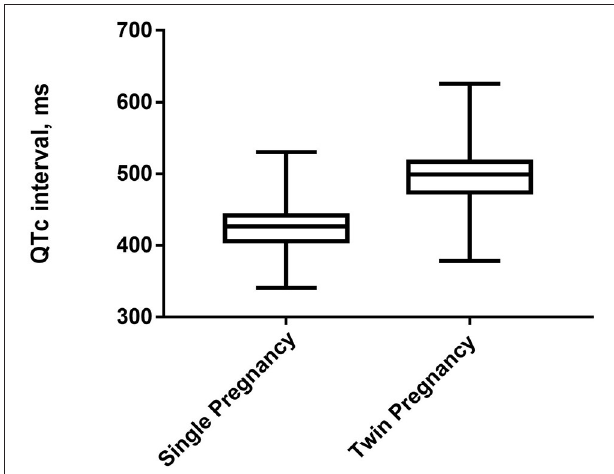
FIGURE 2 | The box and whiskers plot exhibit the median, 25th and 75th percentiles and the range of QTc for single and twin pregnancies.